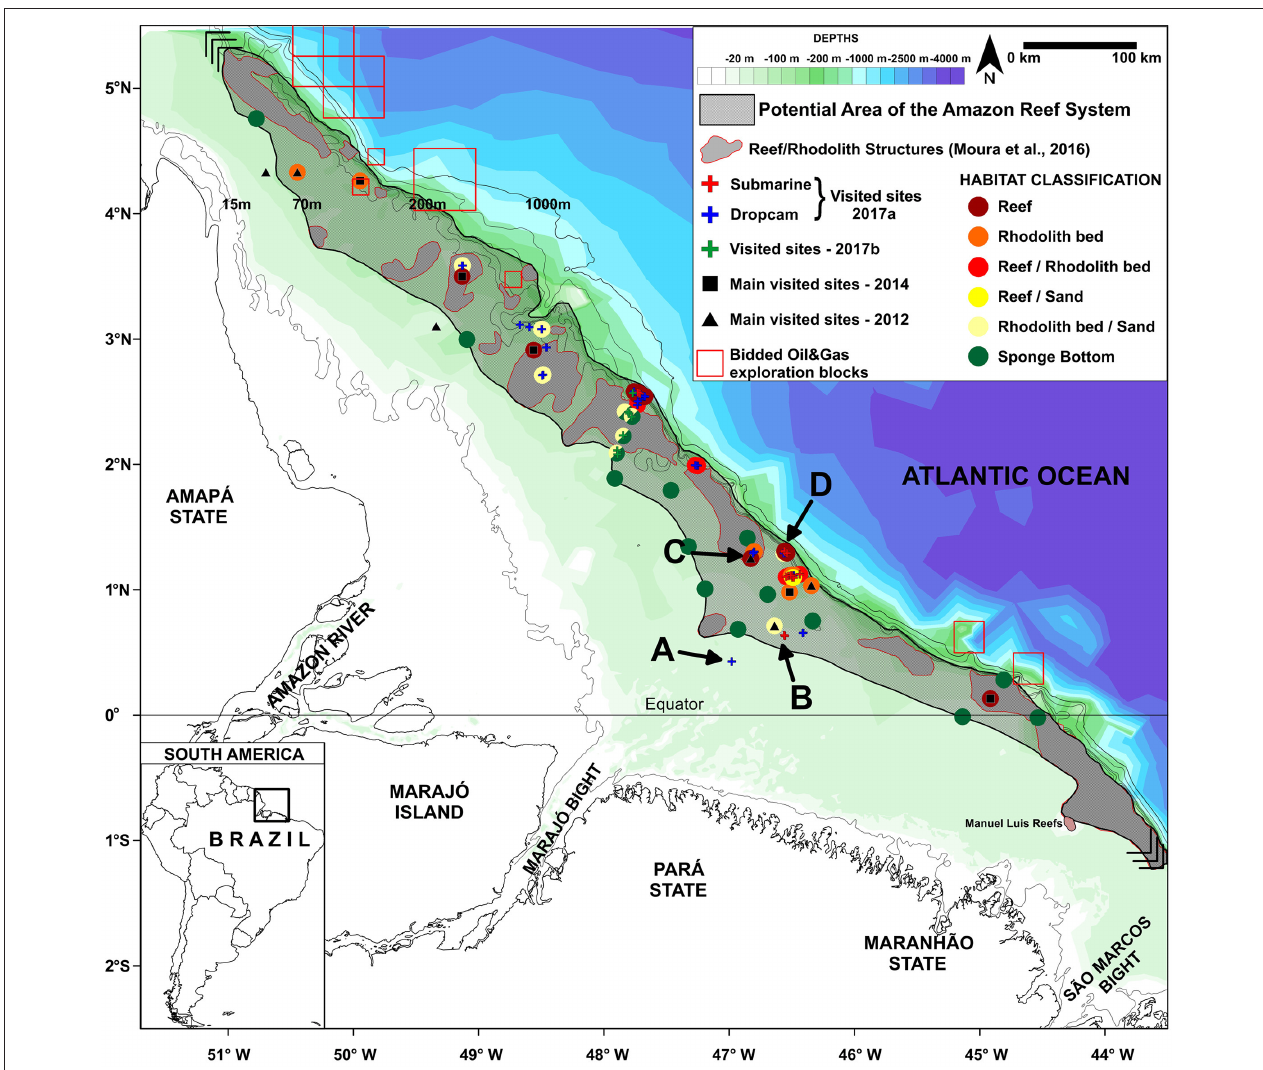
FIGURE 2 | Map of the Great Amazon Reef System (GARS) showing sampling sites. The gray area denotes the potential area covered by mesophotic reefs (56,000 km 2 ). Letters A-D correspond to sites in which images depicted in Figure 1 (showing typical features across a 70–220m depth gradient) are